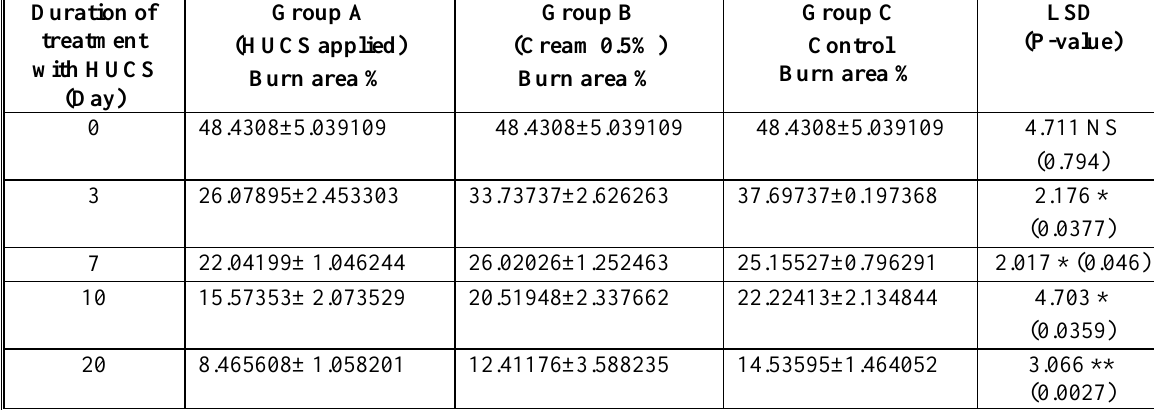
Table 3. Comparative burn area (%) in rabbit groups subjected to hot water (70°C) and chemical burns within NaOH